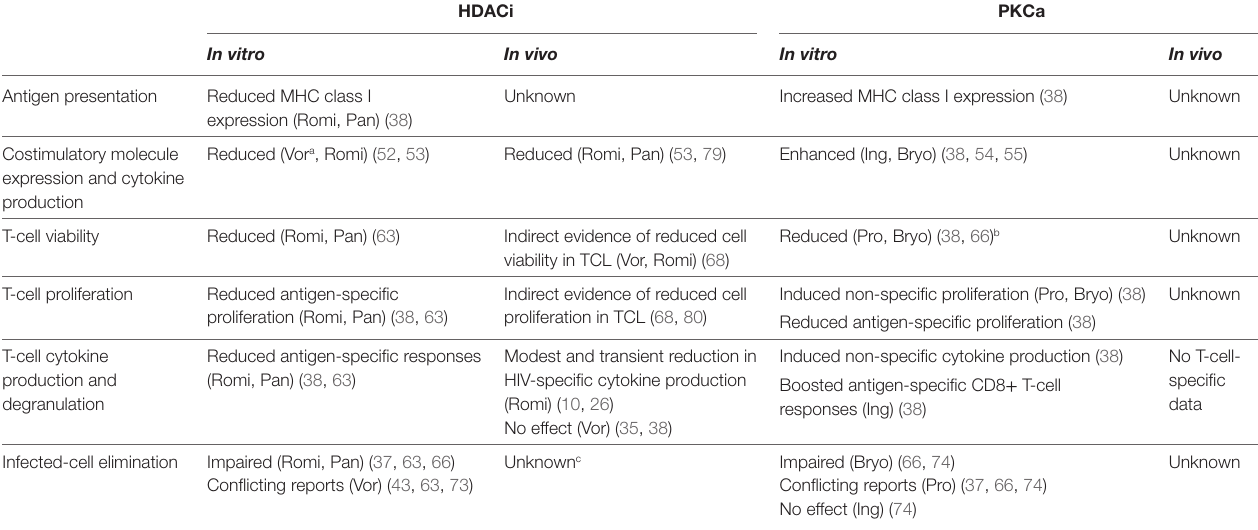
TAbLe 1 | The effects of histone deacetylase inhibitor (HDACi) and PKCa, administered in vitro or in vivo , on CD8 +